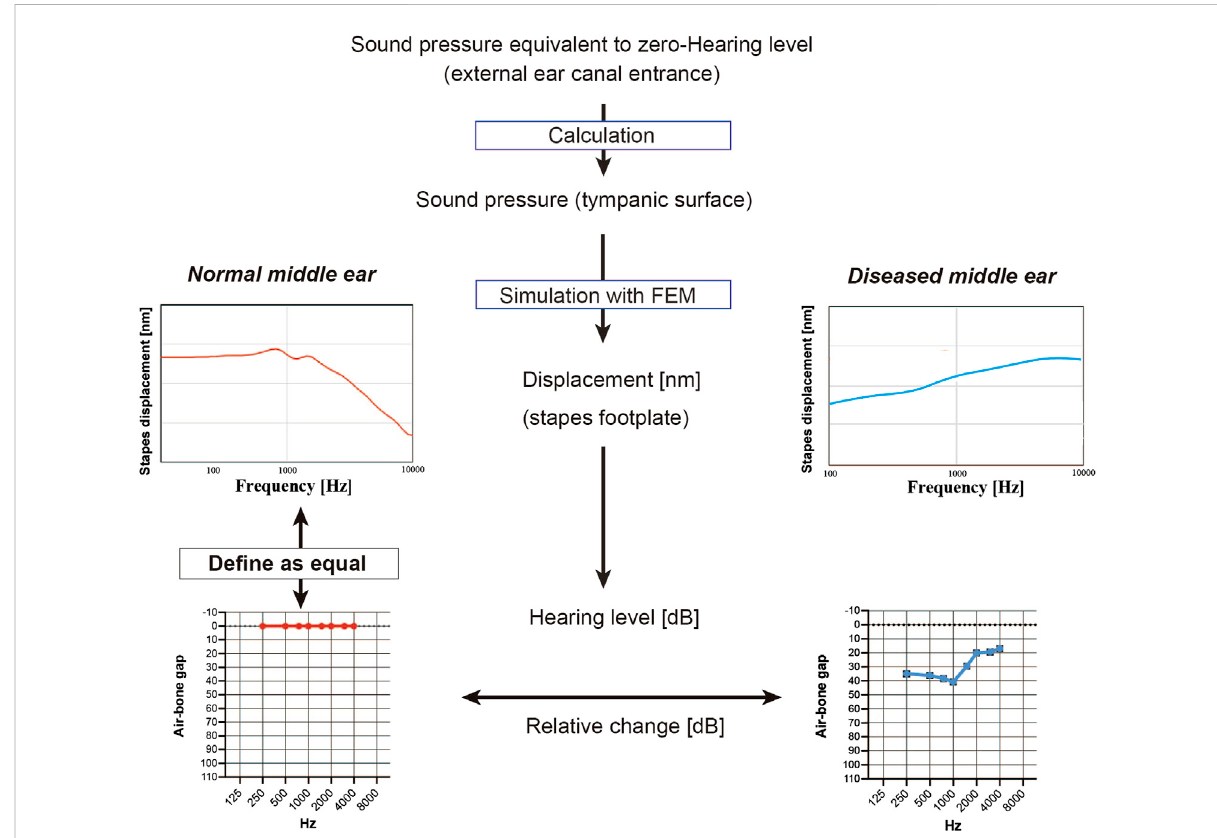
FIGURE 2 Simulation of the audiogram using data from the fi nite element model (FEM). To mimic a hearing test, the sound pressure on the tympanic membrane when the minimum audible sound pressure of each frequency was applied from the entrance of the ear canal was calculated, and the FEMofthenormal middle ear wasused to simulate thedisplacement ofthestapes footplate ateach frequency; these values wereused to de fi nethe zero hearing level in the audiogram. Values for stapes footplate displacement calculated for the FEMs of diseased middle ears were expressed relative to those of the normal middle ear and were represented on the simulated audiogram as the air-bone gap.